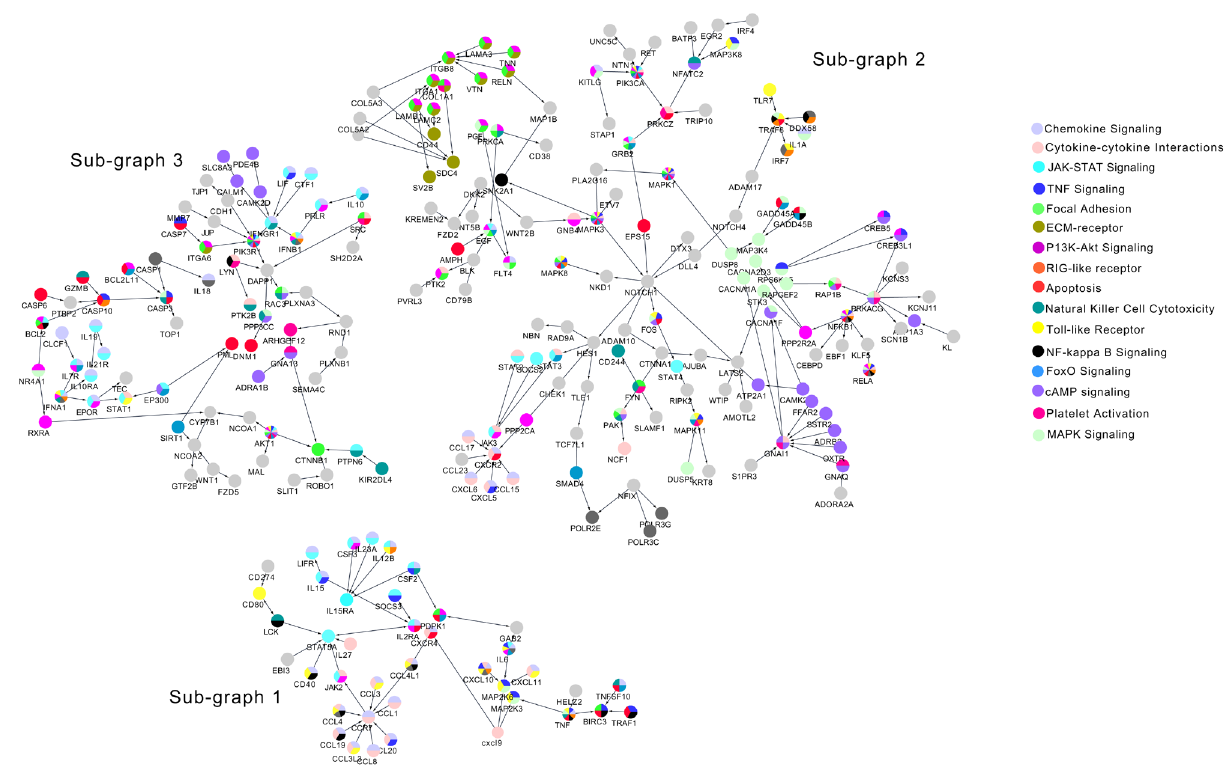
Figure 2. Visualization of the three modulated directed sub-graphs identified by MSF at 6 hpi. The node coloring is associated to KEGG pathways referring to the colors in the legend. The graph edges are from